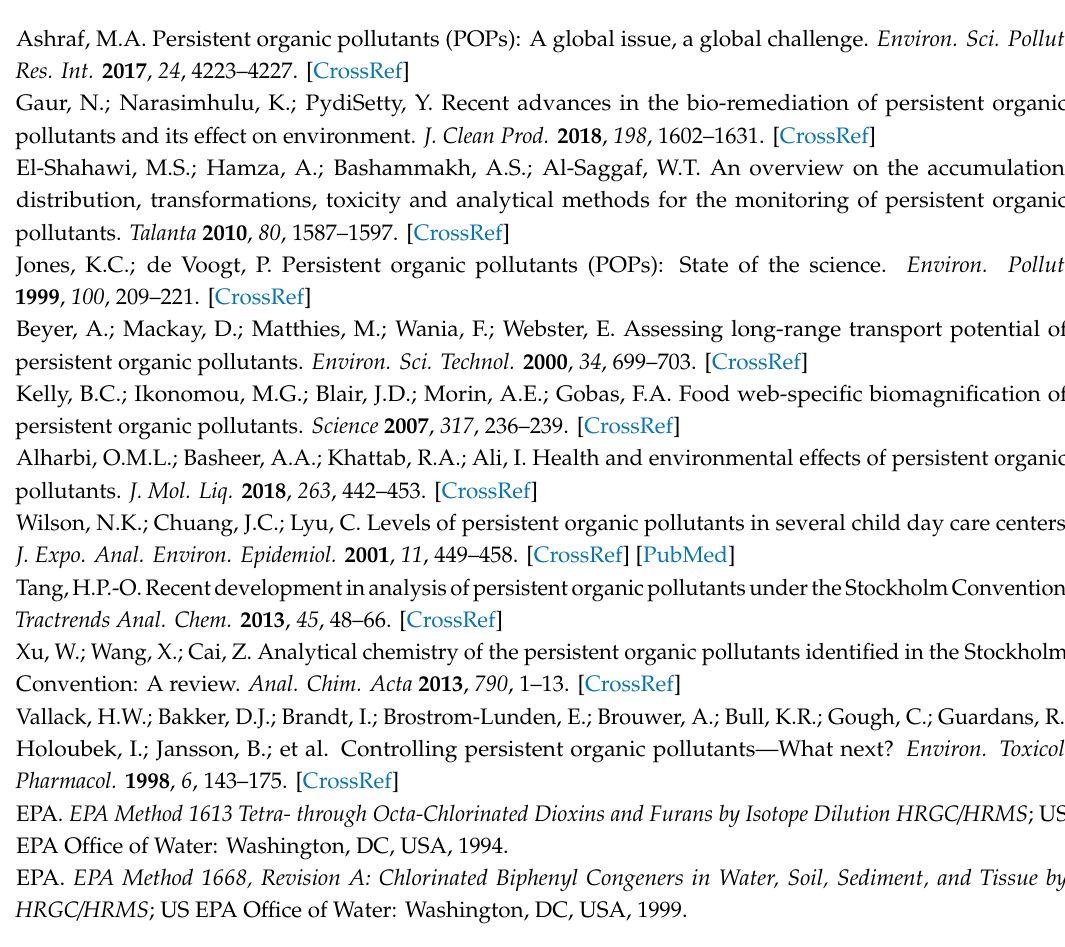
Table S1: Congener Number and its name. Figure S1: Trend plot for 13C-OCDD in Standard Data. Figure S2: Trend plot for 1234789-HpCDF in Spike